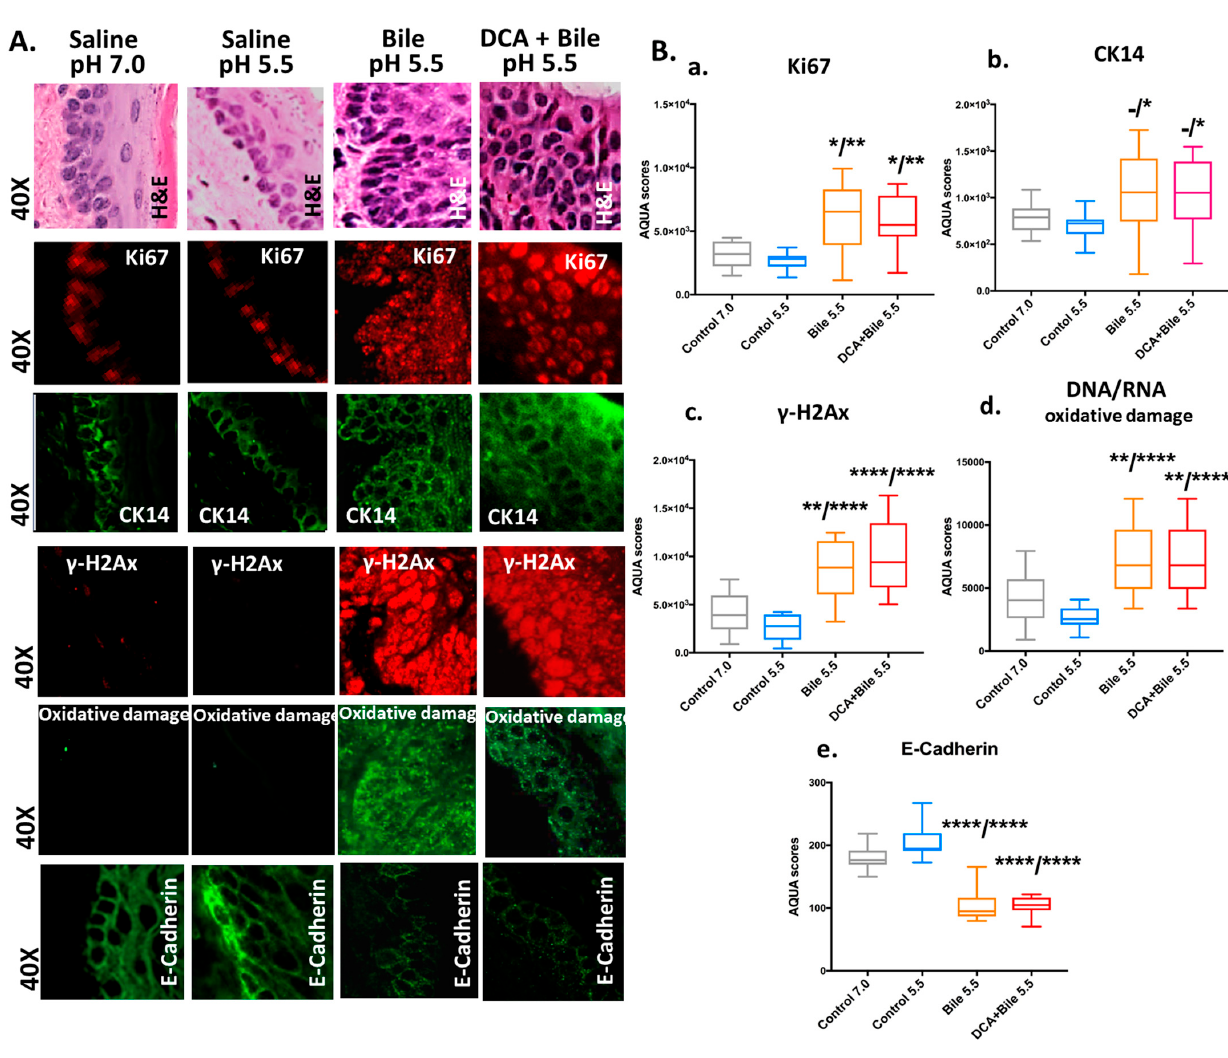
Figure 2. Molecular alterations underlying weakly acidic bile-induced histopathological changes of murine hypopharyngeal mucosa (HM) after 15 weeks of exposure, linked to increased cell proliferation (Ki67 and CK14), DNA damage, and decreased cell–cell interactions (E-Cadherin). ( A ). Immunofluorescence staining and automated quantitative analysis (AQUA) were used for Ki67, γΗ 2 ΑΧ , CK14, DNA/RNA oxidative damage, and E-Cadherin [DyLight®549 used for red; DyLight®488 used for green; DAPI was used for nuclei staining (not seen here)]. ( B ). Graphs created by GraphPad Prism 7.0 indicate a statistically significant difference of AQUA-score means for ( a ) Ki67 (nuclear), ( b ) CK14 (nuclear and cyto- plasmic), ( c ) γΗ 2 ΑΧ (nuclear), ( d ) DNA/RNA oxidative damage markers (nuclear and cytoplasmic), and ( e ) E-Cadherin (membrane/cytoplasmic) between weakly acidic bile with or without DCA vs. controls (* p < 0.01; ** p < 0.001; **** p < 0.00001 ; by t -test; multiple comparisons by Holm-Sidak; GraphPad Prism 7.0).